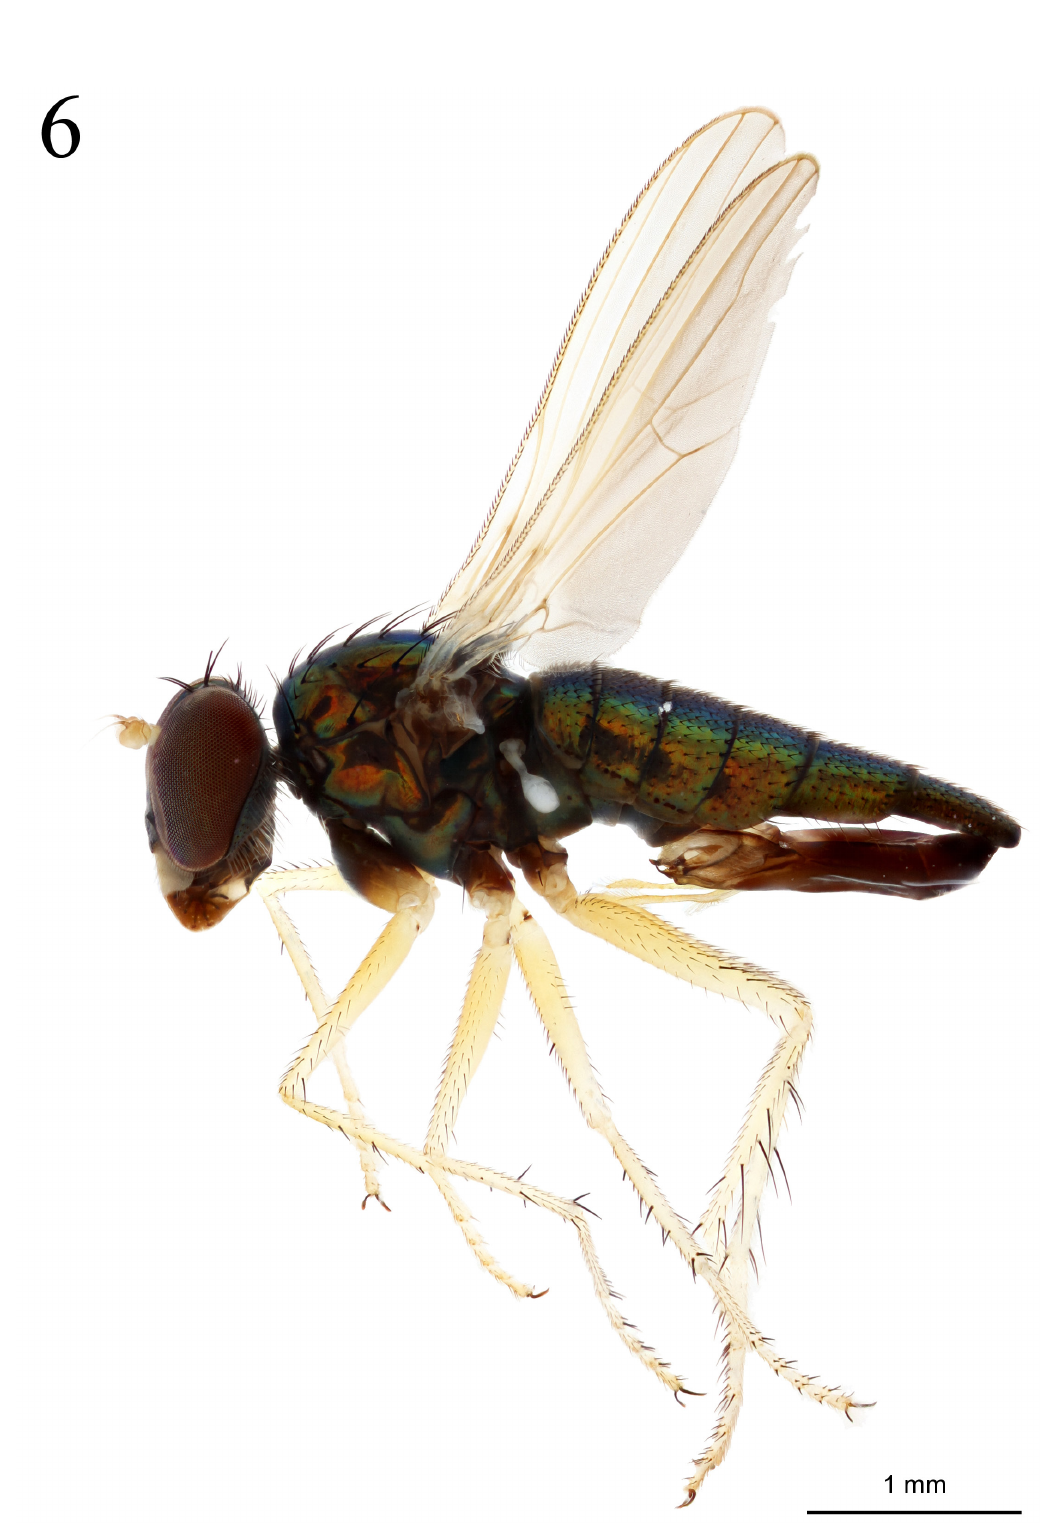
Fig. 6. Thinophilus langkawensis sp. nov., ♂,